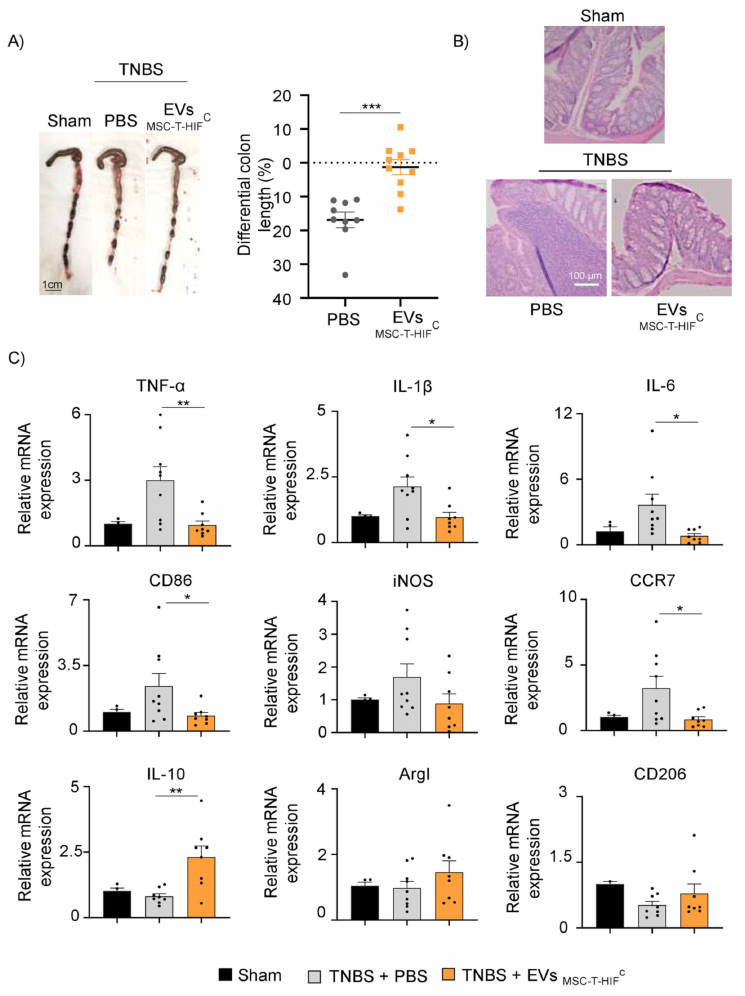
Figure 6. EV MSC-T-HIFC attenuate disease in mice with TNBS-induced colitis. ( A ) Macroscopic images of colonic tissues at day 4 after TNBS administration. Scale bar: 1 cm. Percentage of differential colon length compared with the sham group (horizontal dot line). Data are presented as the mean ± SEM of 9 mice in each group. Unpaired t -test was used for statistical analysis. ( B ) Hematoxylin and eosin staining of representative histological sections of mouse colon in the sham group and in the PBS and EV groups after TNBS administration. Scale bar, 100 µ m. ( C ) TNF α , IL1- β , IL-6, CD86, iNOS, CCR7, IL-10, CD206 and ArgI mRNA expression levels quantified by RT-qPCR in mouse colon in the sham group and in the PBS and EV groups after TNBS administration. Sham group was used as control. Expression level of the target gene in each sample was normalized to β -actin expression. Graphs represent mean ± SEM of fold change of nine independent experiments. Unpaired t -test was used for statistical analysis. * p < 0.05, ** p < 0.01, *** p <